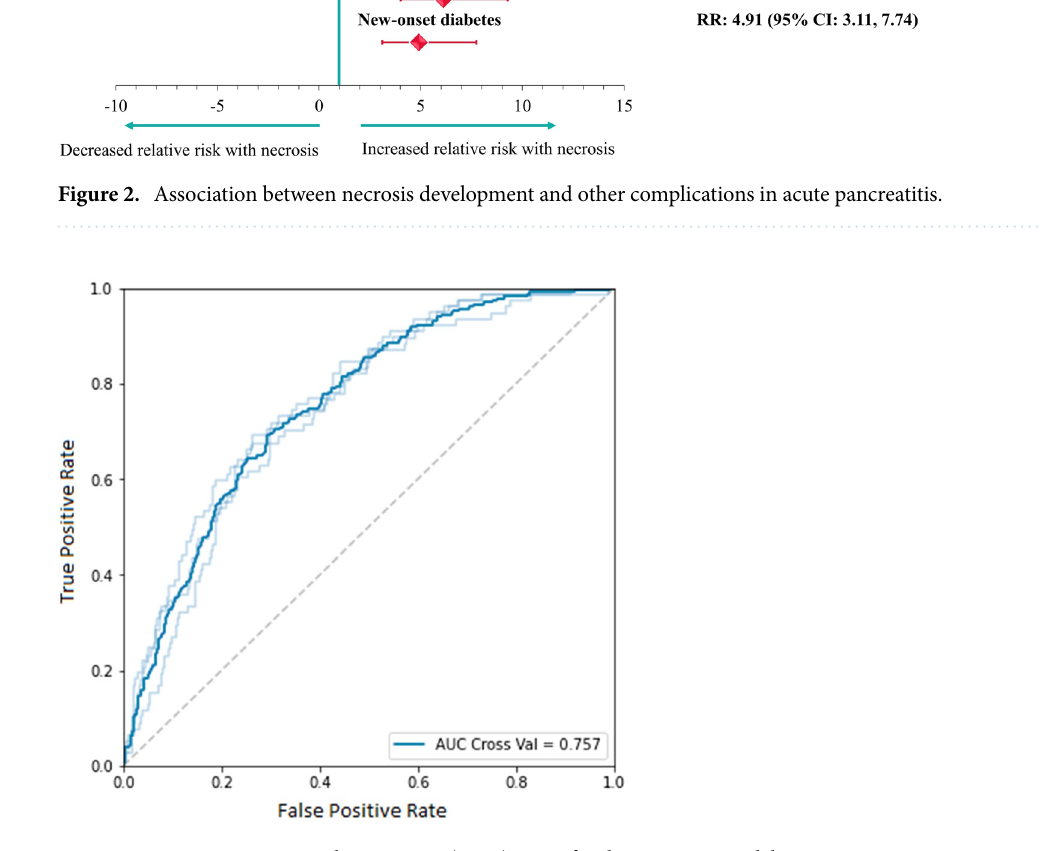
Figure 3. Receiver operating characteristic (ROC) curve for the XGBoost